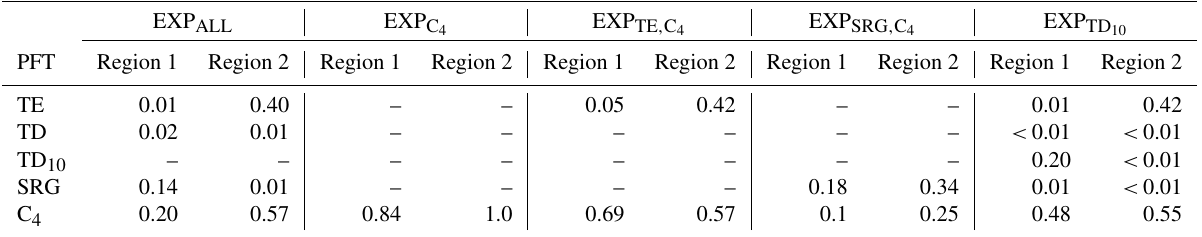
Table 4. Mean cover fractions f i (per vegetated area of a grid cell) of all PFTs with substantial shares of the total vegetation cover in Region 1 (18.65 to 22.38 ◦ N, 4.69 to 30.94 ◦ E) and Region 2 (11.19 to 18.65 ◦ N, 15.94 ◦ W to 19.69 ◦ E). Values represent 100-year averages of the experiment with the standard PFT set EXP ALL and simulations with modified PFT composition (tropical evergreen tree – TE, raingreen shrub – SRG, C 4 grass – C 4 , frost-tolerant tropical deciduous tree – TD 10